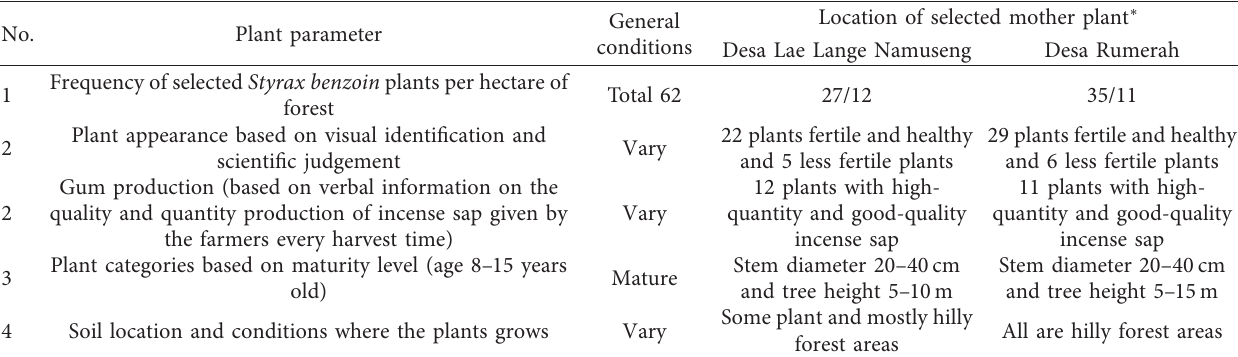
Table 1: The description of Sumatra Benzoin ( Styrax benzoin Dryander) selected as mother plants trees in the forest area at District Sitellu Tali Urang Julu.